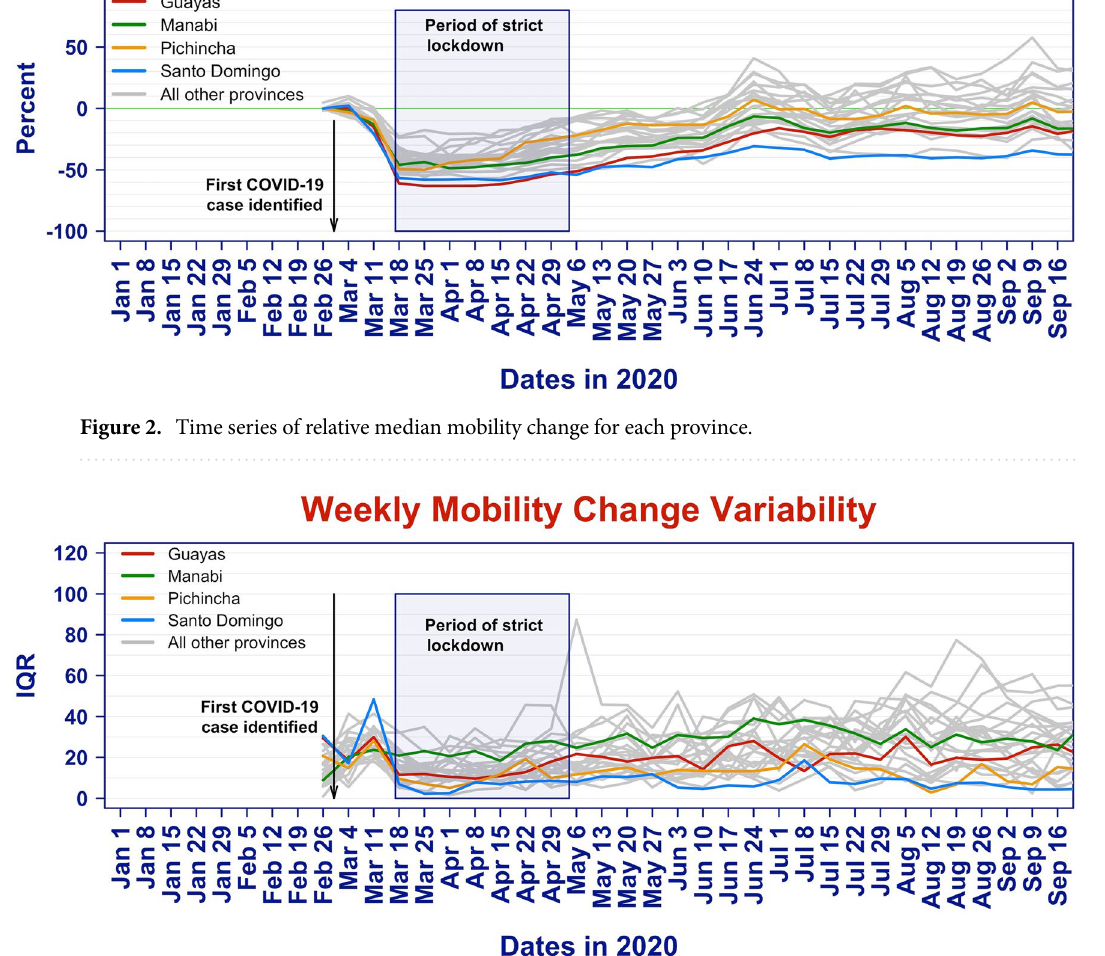
Figure 3. Time series of mobility change variability (IQR) for all Ecuadorian